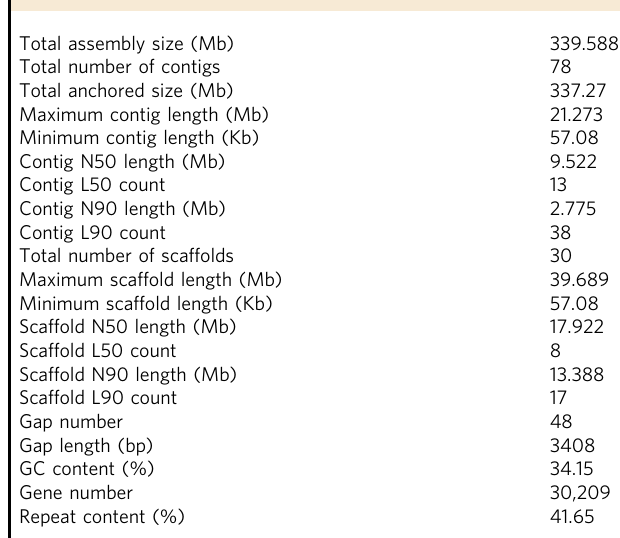
Table 1 Statistics of the Cushion willow genome